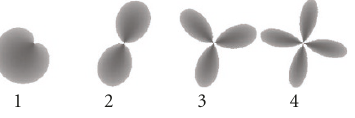
Figure 17: “Combined”